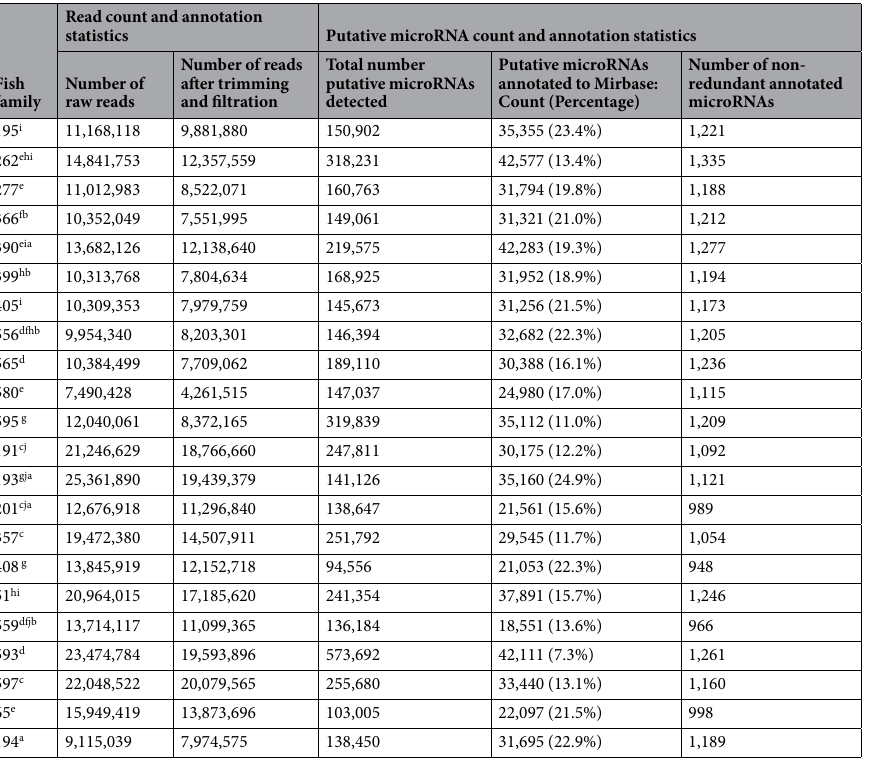
Table 1. Small RNA sequencing and annotation statistics of 22 samples used in the study. Table shows name of fish families used for different traits, number of raw reads, number of reads after trimming/filtration, total number of putative microRNAs detected in each sample and number of putative microRNAs annotated to the miRBase microRNA reference. Last column represents the number of non-redundant microRNAs annotated to MiRBase microRNA reference in each sample. Note: a High WBW, b Low WBW, c High muscle yield, d Low muscle yield, e High crude fat, f Low crude fat, g High shear, h Low shear, i High muscle whiteness, j Low muscle whiteness and families used for more than one muscle traits are indicated with corresponding multiple